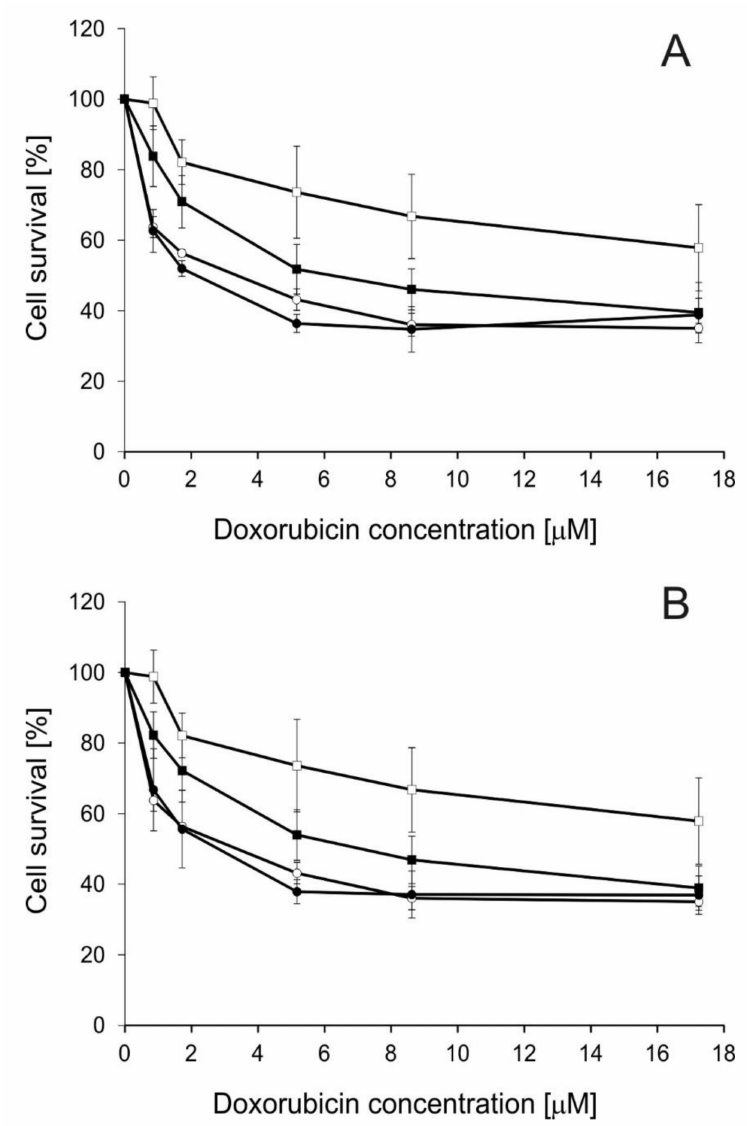
Figure 2. The changes in doxorubicin (Dox) cytotoxicity in LoVo (circles) and LoVo / Dx cells (squares) caused by SILA-409 at 0.5 µ M ( A ) and SILA-421 at 1 µ M ( B ). Open symbols represent cells treated with Dox only, whereas full symbols represent cells treated with Dox and the modulator. Means of three experiments ± SD are